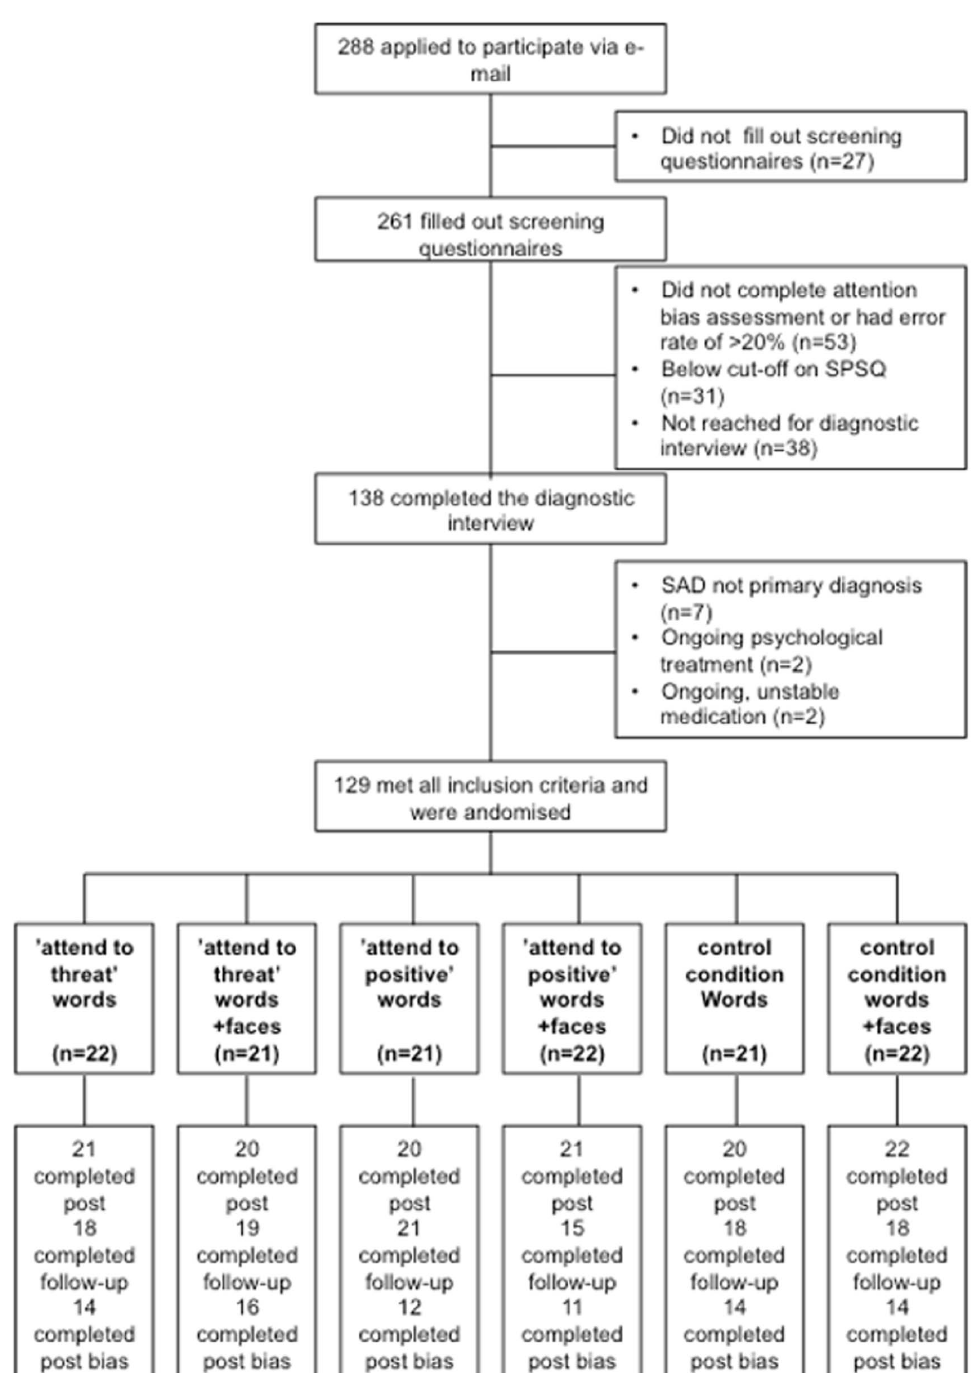
Figure 1. Flow chart of participants.